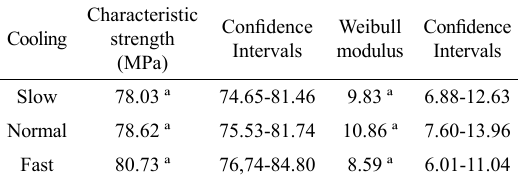
Table 3. Weibull modulus and characteristic strength with a confidence interval of 95% to the three different cooling methods. Characteristic Confidence Cooling strength Intervals (MPa)